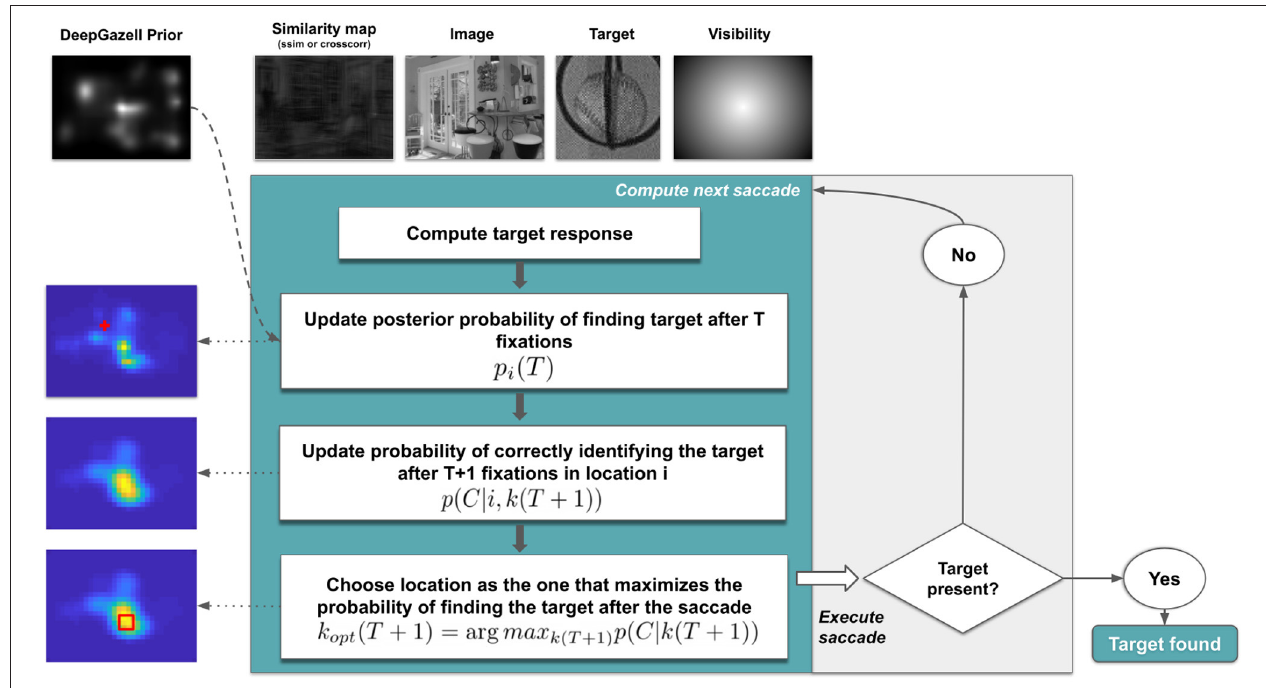
FIGURE 1 | Bayesian model scheme. Simplified outline of the main framework. To compute each saccade (cyan box), in the first instance, the target response (first white box) is precalculated for each possible location ( W ) using the selected similarity: presence/absence of the target IBS , cross-correlation cIBS , or